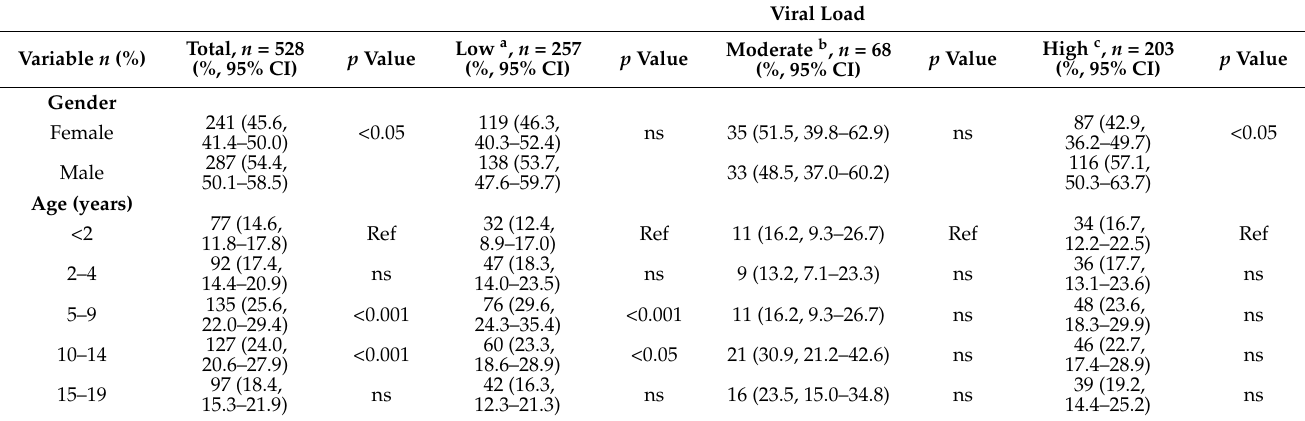
Table 2. Demographic and clinical features of the study population diagnosed by RT-qPCR related to viral